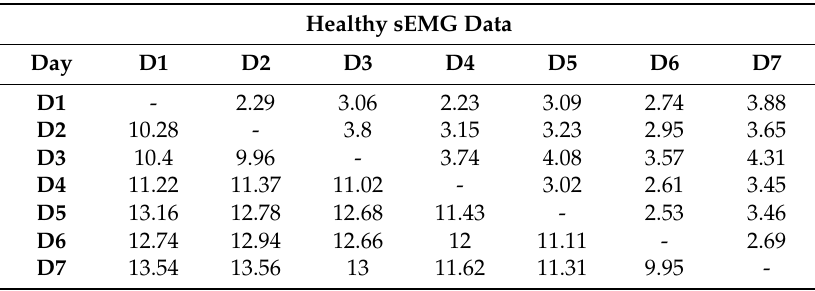
Table 1. Stacked sparse autoencoder (SSAE) vs. linear discriminant analysis (LDA) performance and In each matrix, the upper diagonal triangle represents the mean classification errors obtained with SSAE and the lower diagonal triangle represents errors obtained with LDA for corresponding pairs of